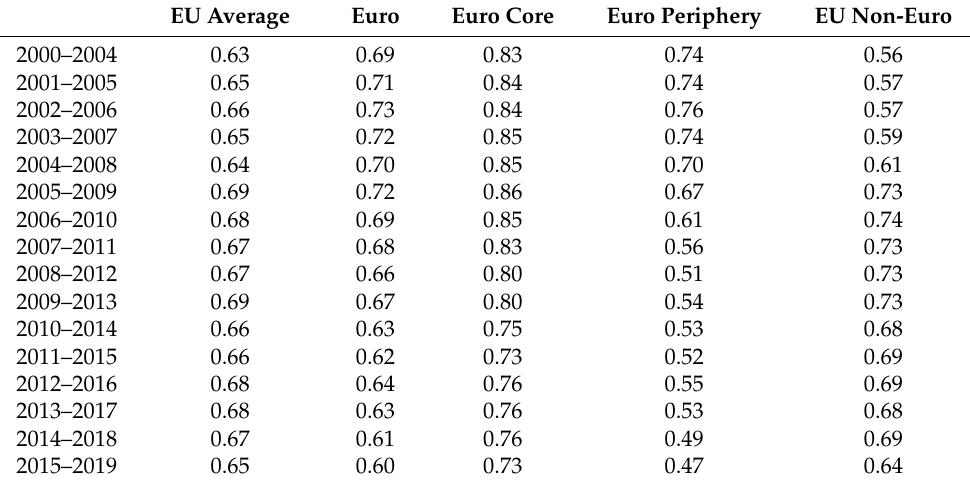
Table 3. Labour productivity growth rates—averages of country-level correlation coefficients for different country groups—labour productivity growth rates. EU Average Euro Euro Core Euro